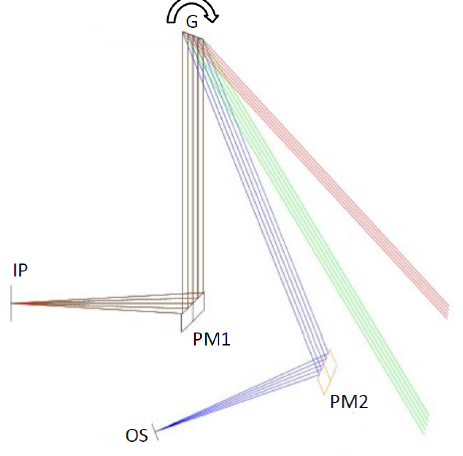
Figure 1. Schematic diagram of the TuPS diffraction system’s lay-